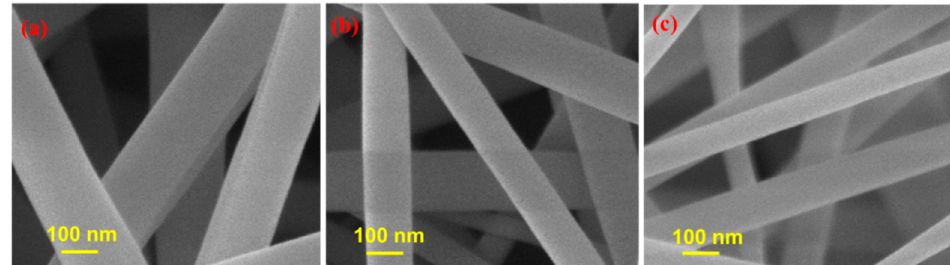
Figure 1. SEM micrographs of the PVP-ZnAc fibers at a constant distance of 12 cm; a flow rate of 1 mL/h; and applied potential of ( a ) 12 kV, ( b ) 14 kV, and ( c ) 16 kV.